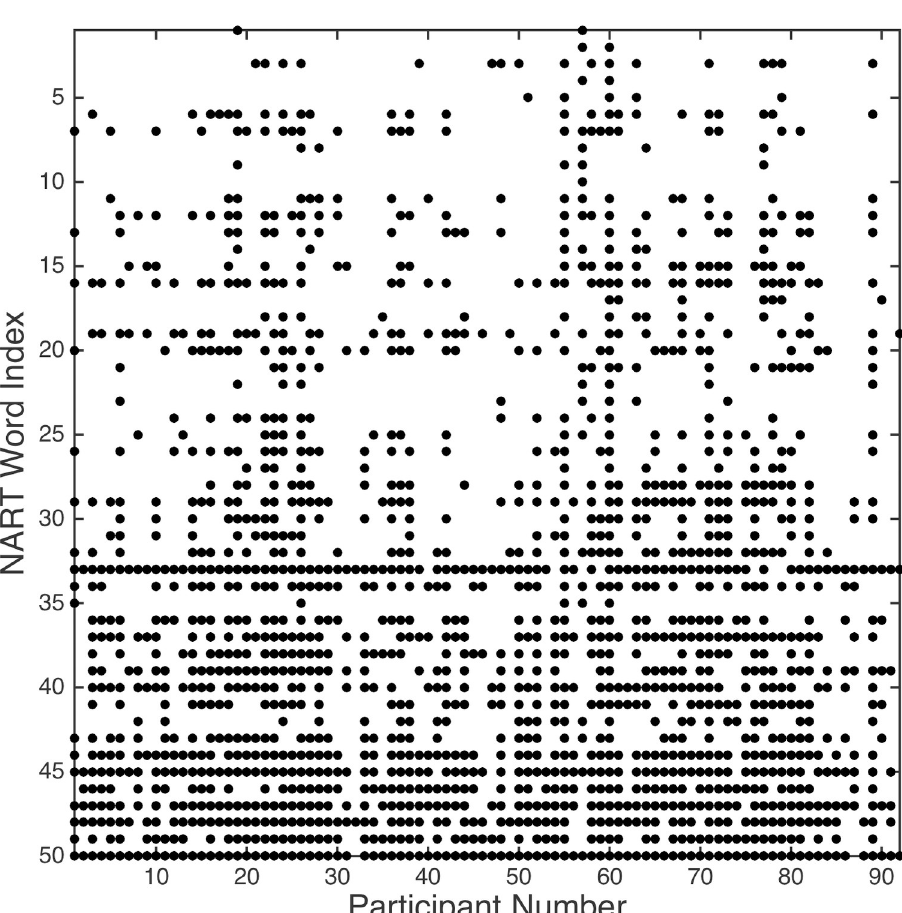
Fig 1. 2-D bit matrix for all participants and NART word responses in which a black dot denotes a pronunciation error.